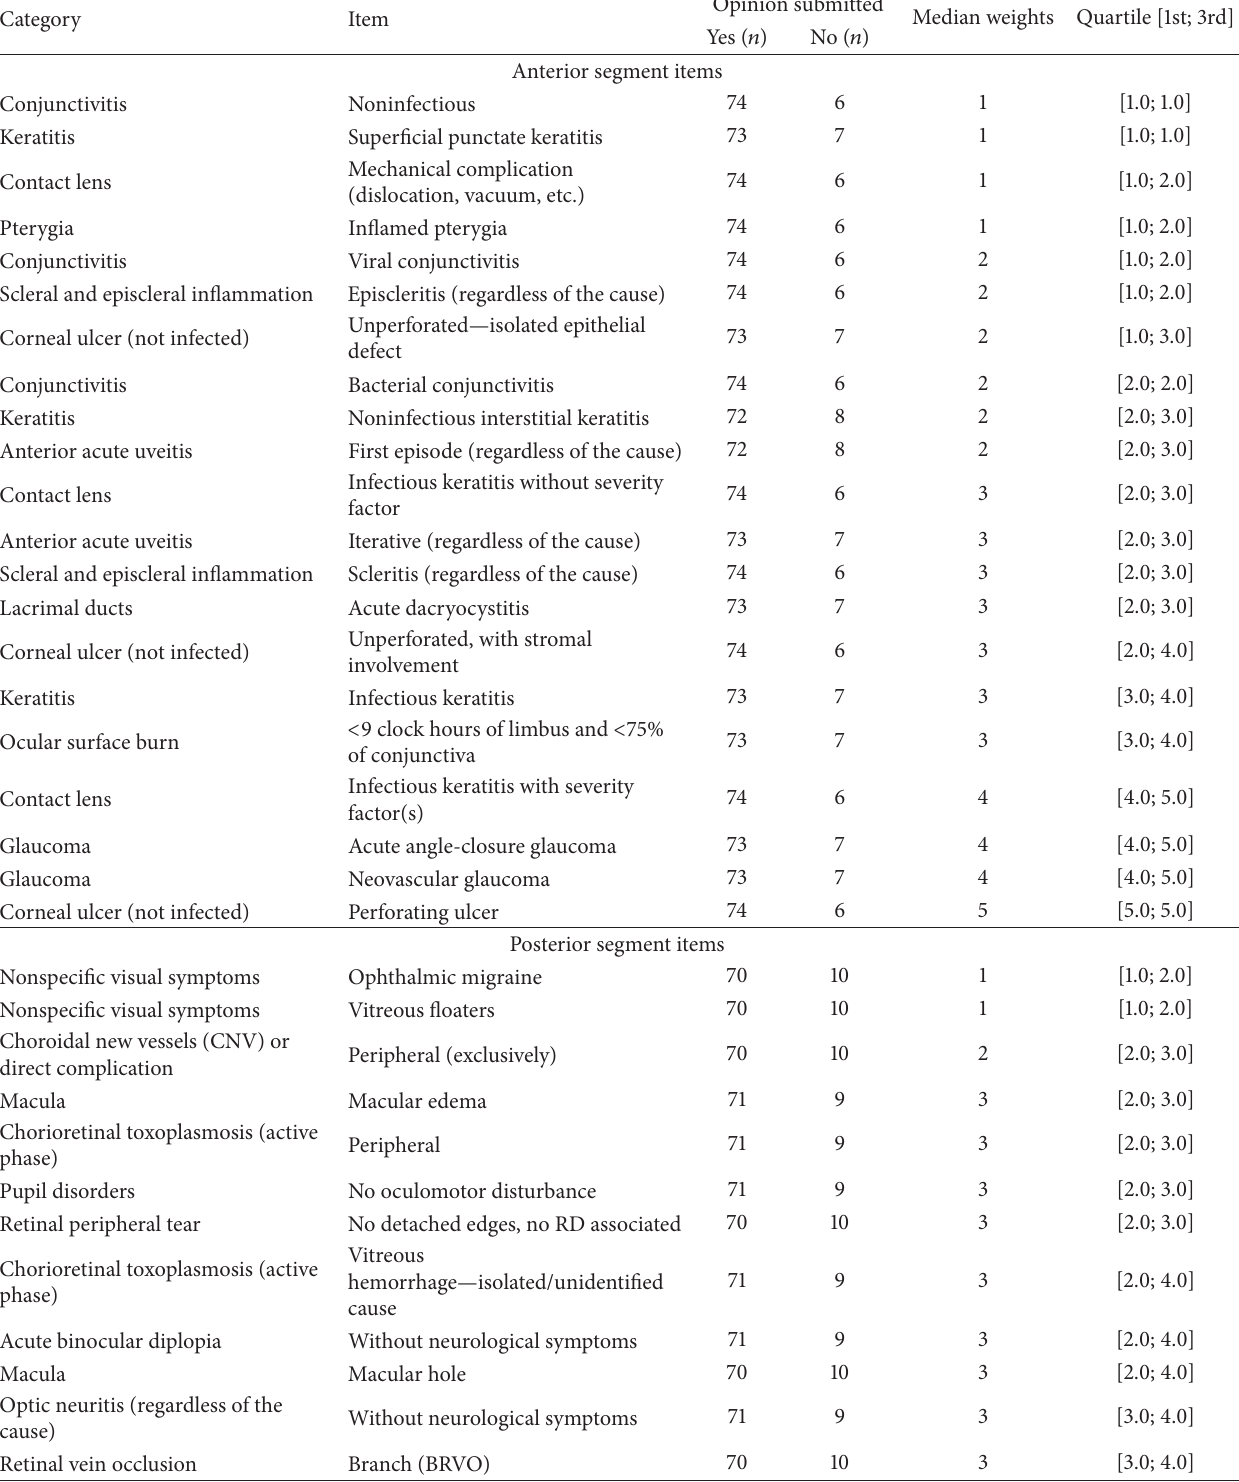
Table 2: Consensus reached on items from the 4 main categories of ocular emergencies and sorted by median weight rating